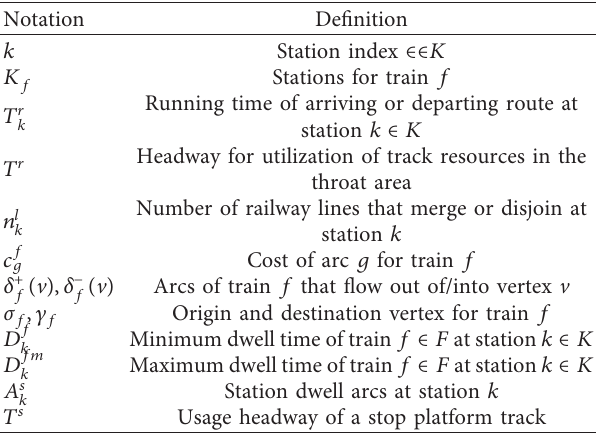
Table 2: Model notations.